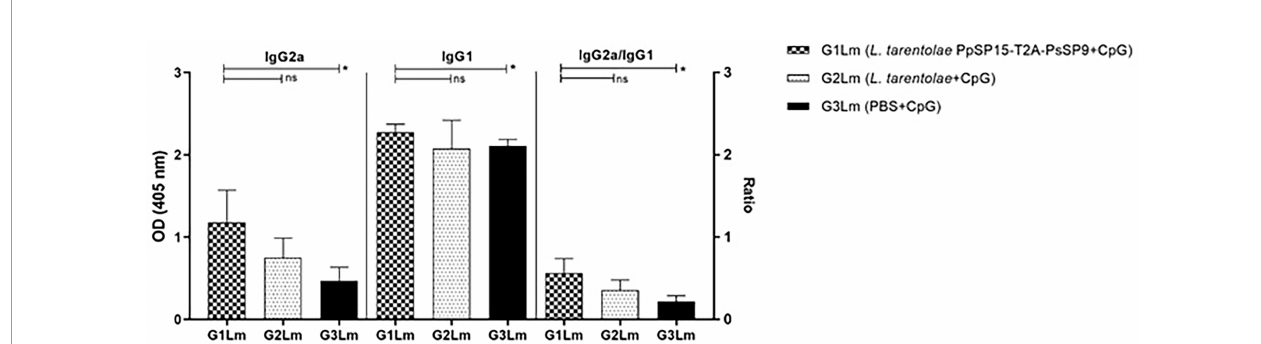
FIGURE 6 | Analysis of antigen-speci fi c antibody responses in vaccinated and control mice by ELISA post-infection with L. major . All mice (n=8 per group) were bled from the venous sinus to collect sera at week 11 post-challenge. The level of IgG2a, IgG1, and IgG2a/IgG1 ratio were evaluated in response to L. major F/T antigen. Data are representative of two independent experiments. The results are presented as mean ± SE and student t-test was used for statistical analysis (* p < 0.05; ns, non-signi fi cant).